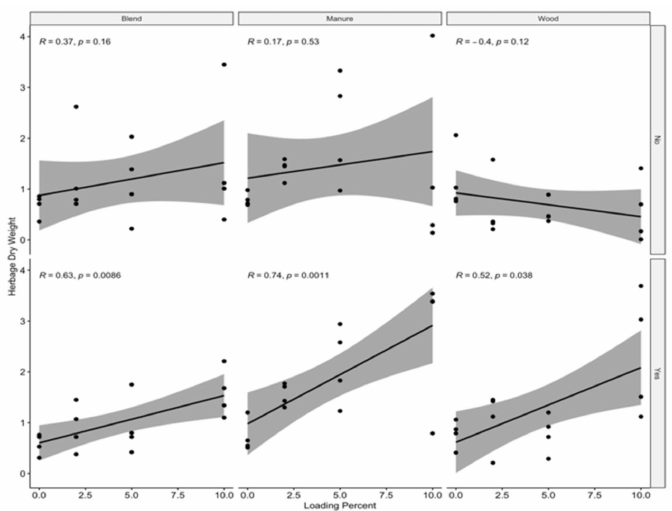
Figure 5. H-DW x loading percent, Spearman’s correlation for L. multiflorum by BC type and saturation (yes for